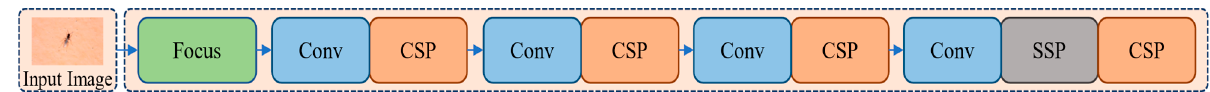
Figure 2. The Backbone part of the proposed work with the extended CSP module.